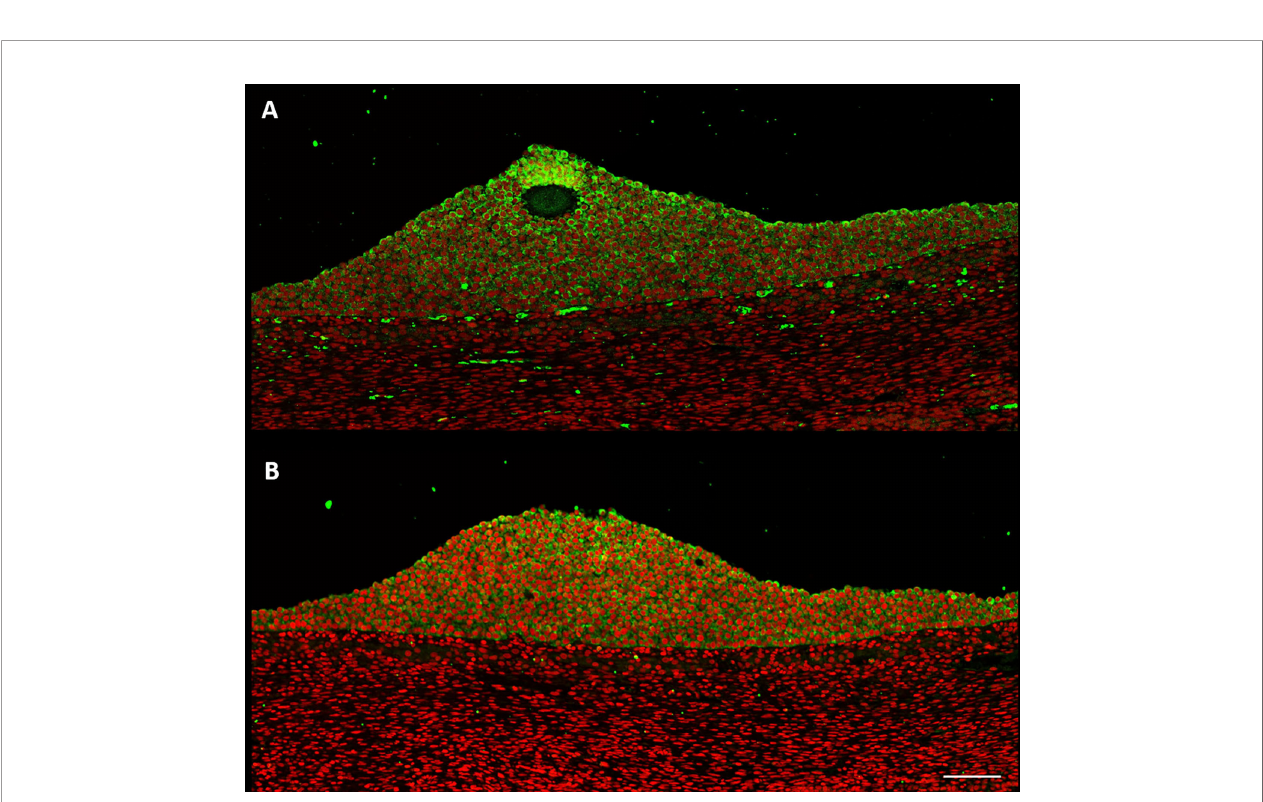
FIGURE 3 | Human small antral follicle (5 mm). (A) AMH C (green) is expressed in cumulus cells with increasing intensity toward the oocyte. Nucleus (red). (B) AMH N (green) is expressed in cumulus cells close to the oocyte. Scale bar: 100